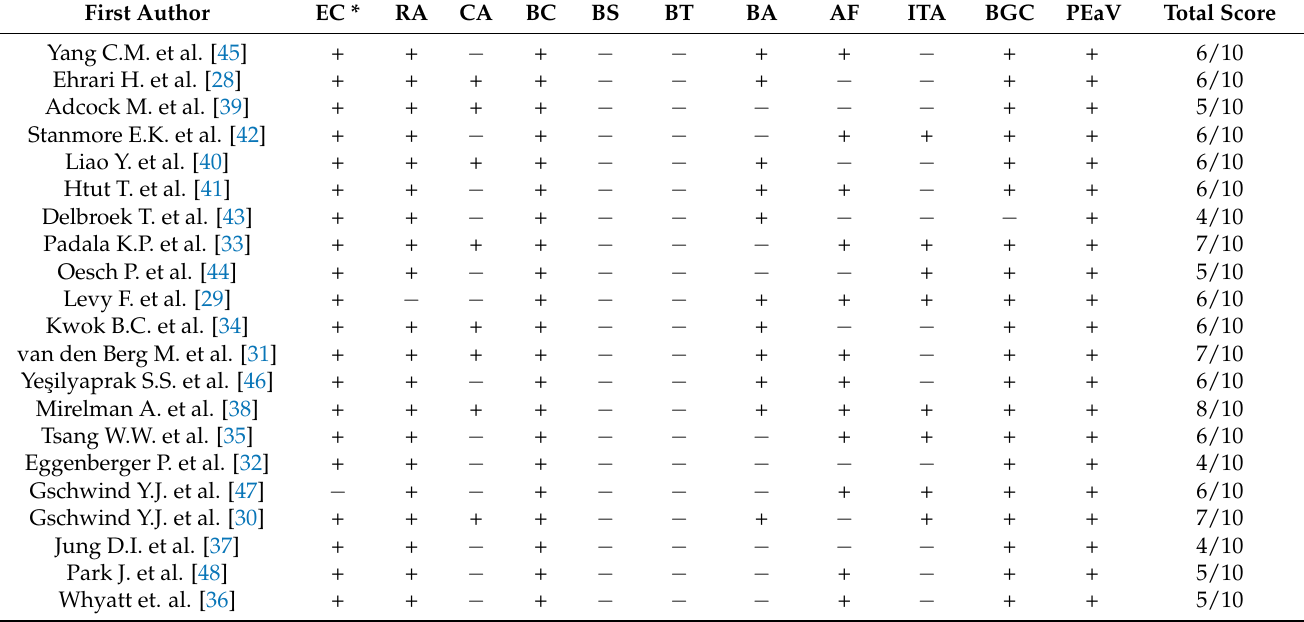
Table 4. The methodological quality assessment of the articles included in PEDro